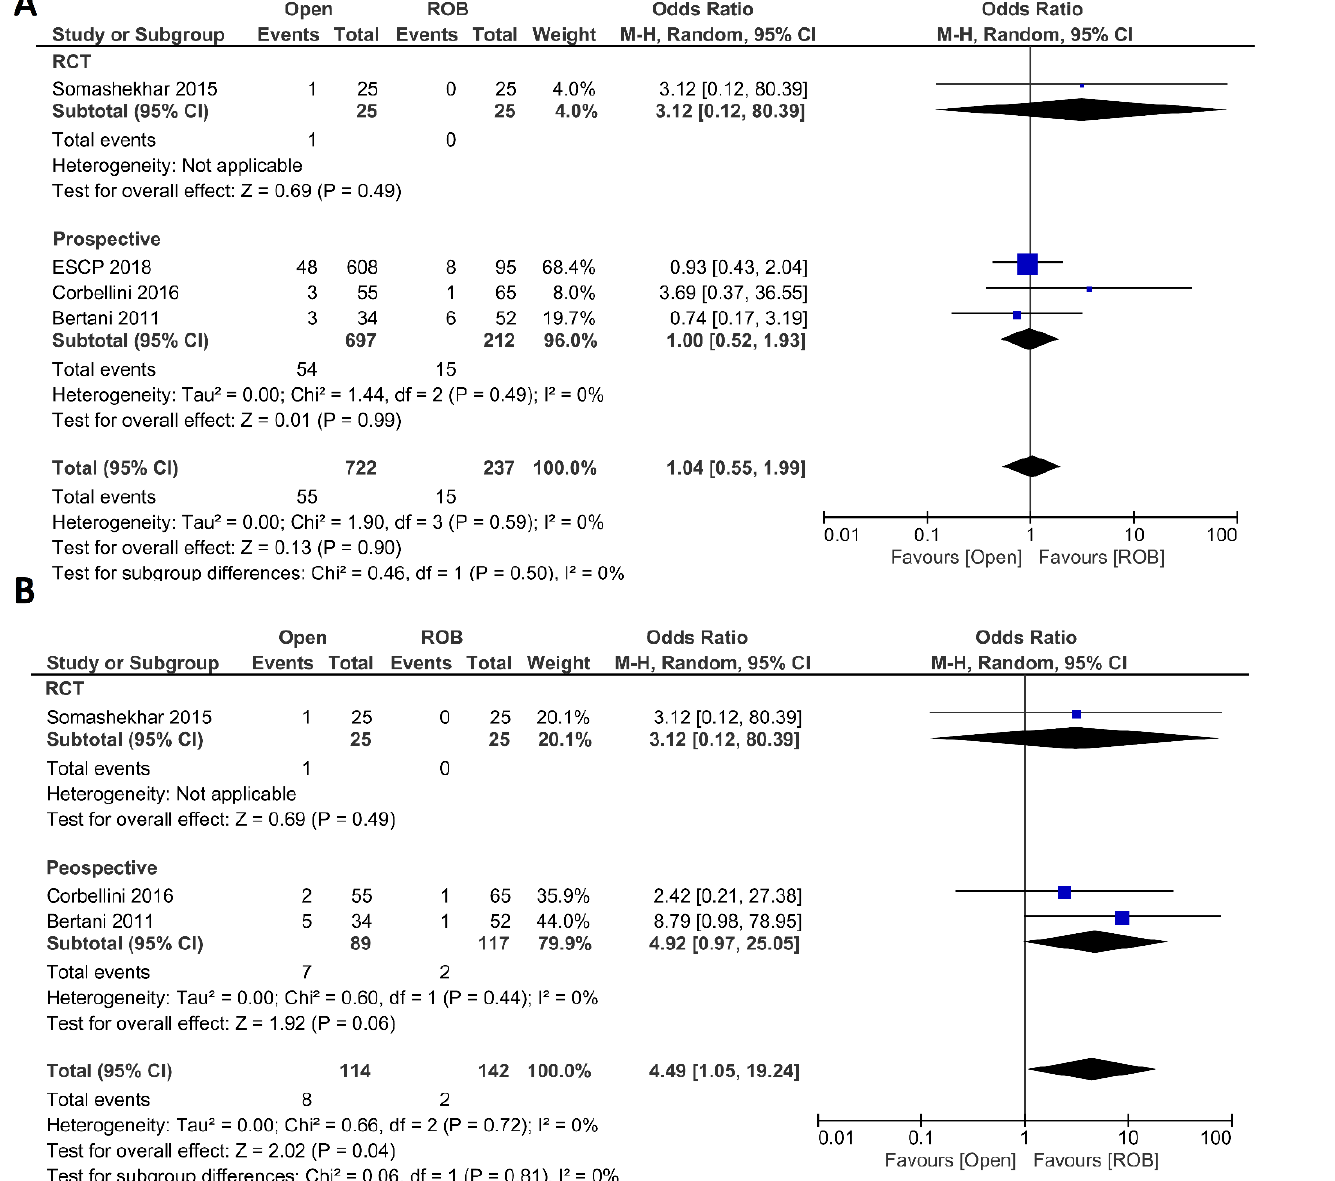
Figure 3. Forest plots comparing ( A ) anastomotic leakage [18,20,44,46] and ( B ) surgical site infec- tion [18,20,46] between robotic and open rectal resection (blue boxes representing odd ratios, arrows representing 95% confidence intervals, and diamonds representing point estimates of pooled odd ratios or mean differences).